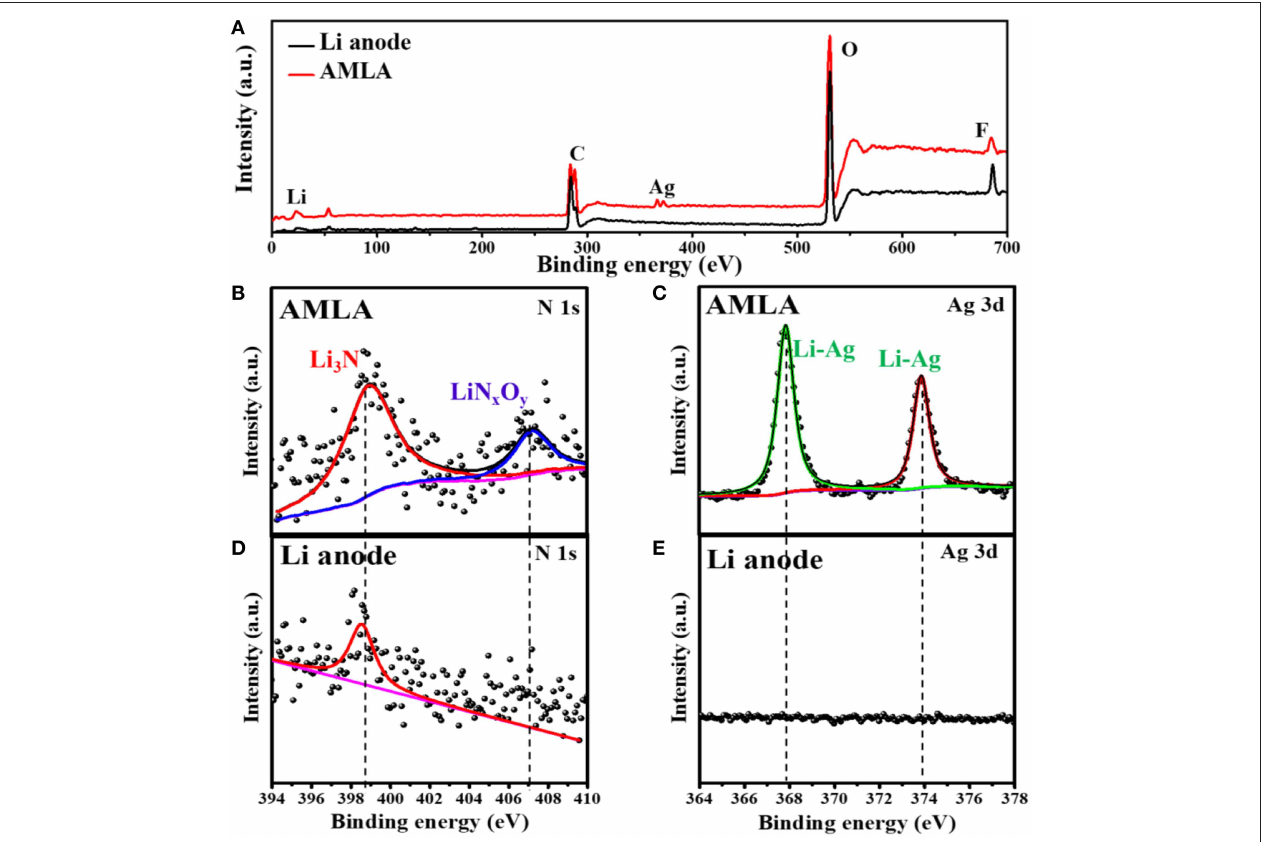
FIGURE 5 | The XPS spectra of Li anode and AMLA after cycles. The full XPS spectra (A) of Li anode (back) and AMLA (red) electrodes after cycles. XPS spectra of different element of AMLA: (B) N 1s and (C) Ag 3d. XPS spectra of different element of Li anode: (D) N 1s and (E) Ag